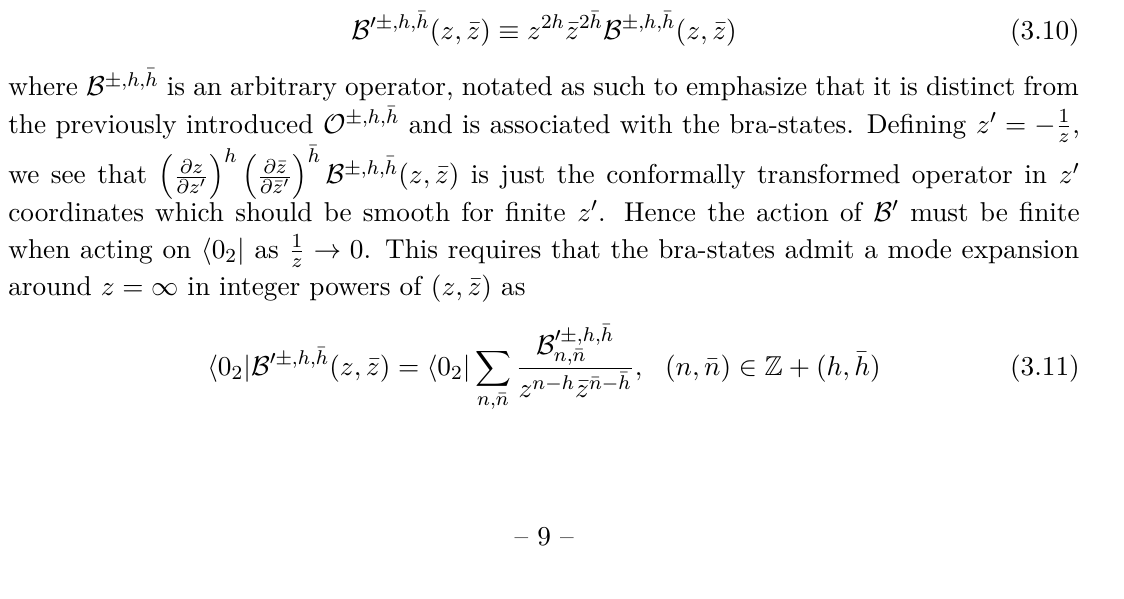
JHEP09(2021)132